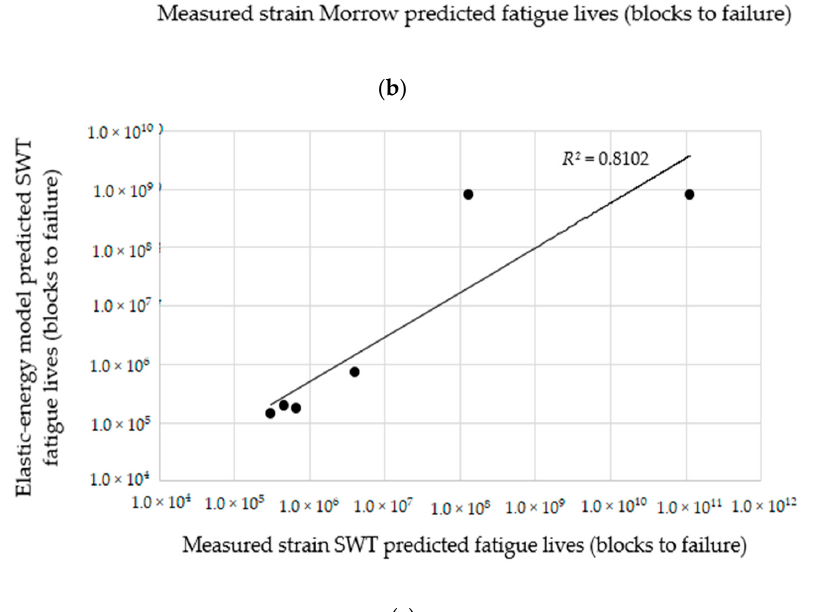
Figure 19. Scatter band for strain measurement and elastic-energy model fatigue life using various models: ( a ) Coffin-Manson, ( b ) Morrow, ( c ) SWT.